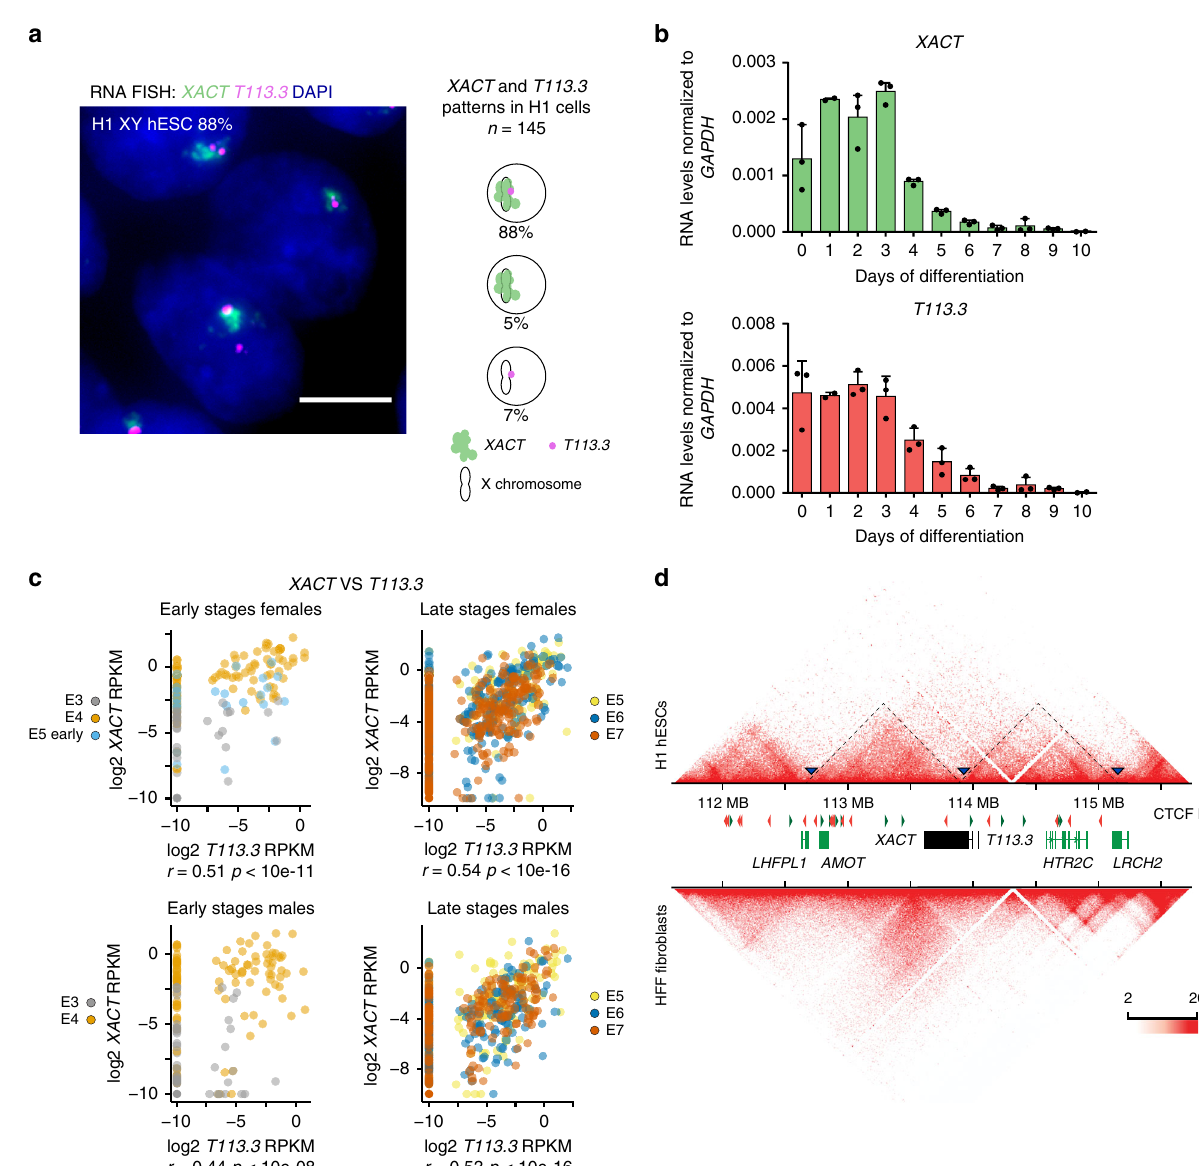
Fig. 2 XACT and T113 are co-regulated in pluripotent contexts. a Analysis of XACT (green) and T113.3 (magenta) expression by RNA-FISH in male H1 hESCs. Percentage of cells co-expressing XACT and T113.3 from the same locus is indicated. Quanti fi cation of the different patterns of expression is represented on the right ( n = 145). The white scale bar represents 5 µ m. b RT-qPCR analysis of XACT and T113.3 expression during a 10-day undirected differentiation of H1 hESCs. The bar charts correspond to the average of three independent differentiation experiments. Error bars indicate the standard deviation (SD). The correlation coef fi cient for the expression dynamics of the two genes is shown ( r = 0.94, Pearson correlation). c Plot of T113.3 vs. XACT expression levels (log2 reads per kilobase per million mapped reads [RPKM]) in early (E3, E4, and early E5) and late stage (E5, E6, and E7) female (upper panels) and male (lower panels) pre-implantation embryos, with corresponding Spearman ’ s correlation score and p -value. Dataset from ref. 33 . d Hi-C heatmap of the LHFPL1 / LRCH2 locus in H1 hESCs and in HFF 43 visualized with Juicebox 70 . Red and green arrows indicate the orientation of CTCF binding sites. Blue arrows and dotted lines show the boundaries of the domains in H1